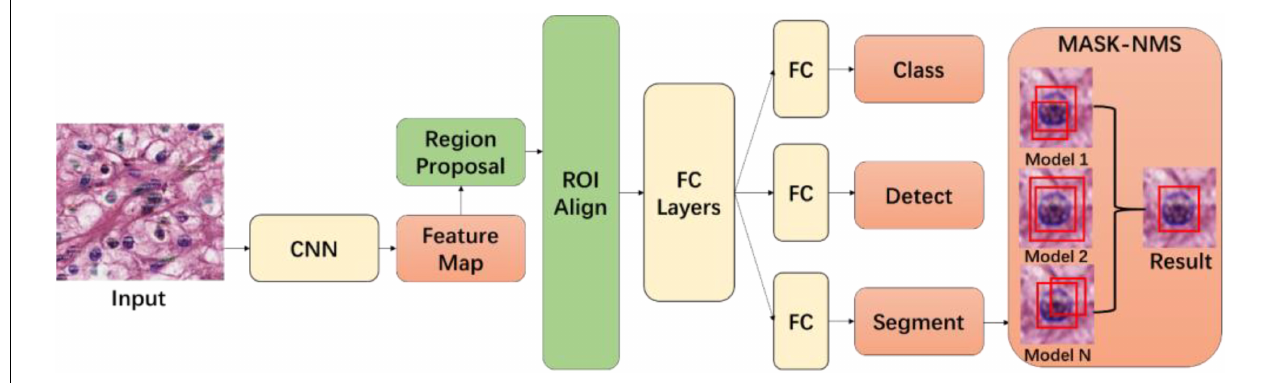
FIGURE 1 | Tissue image segmentation model. The first part of the model consists of the Mask-RCNN module. Output from this module is input to the MASK-NMS module for final segmentation prediction